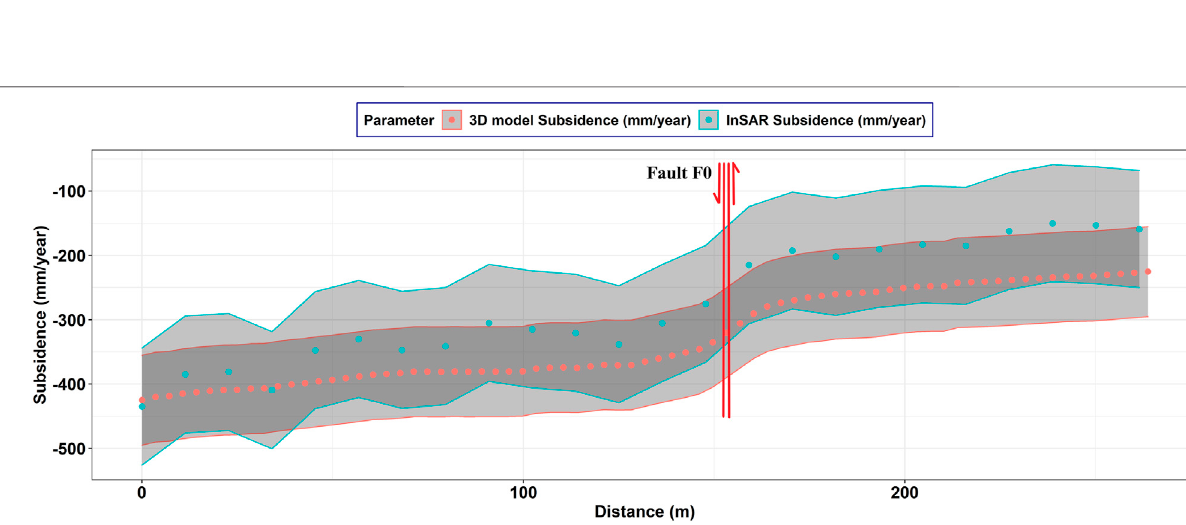
Frontiers in Environmental Science |